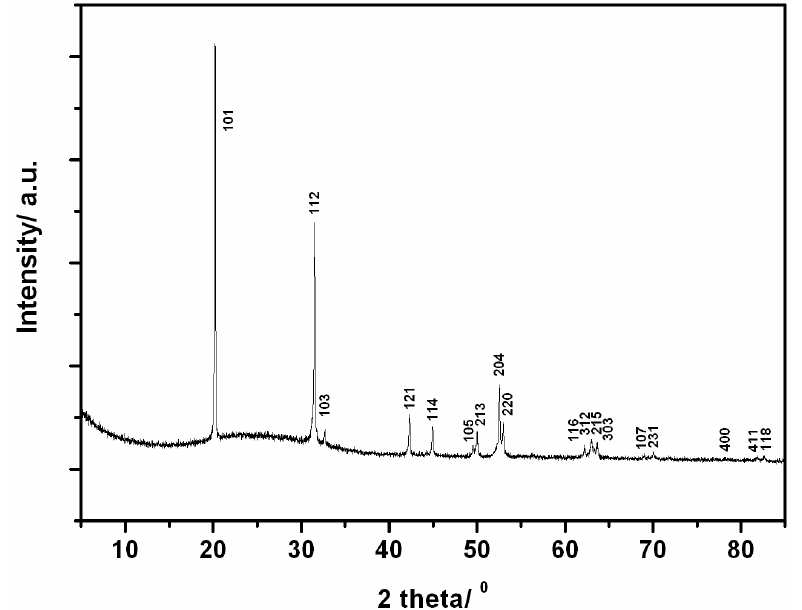
Figure 4. PXD data for tetragonal Li under vacuum (sample